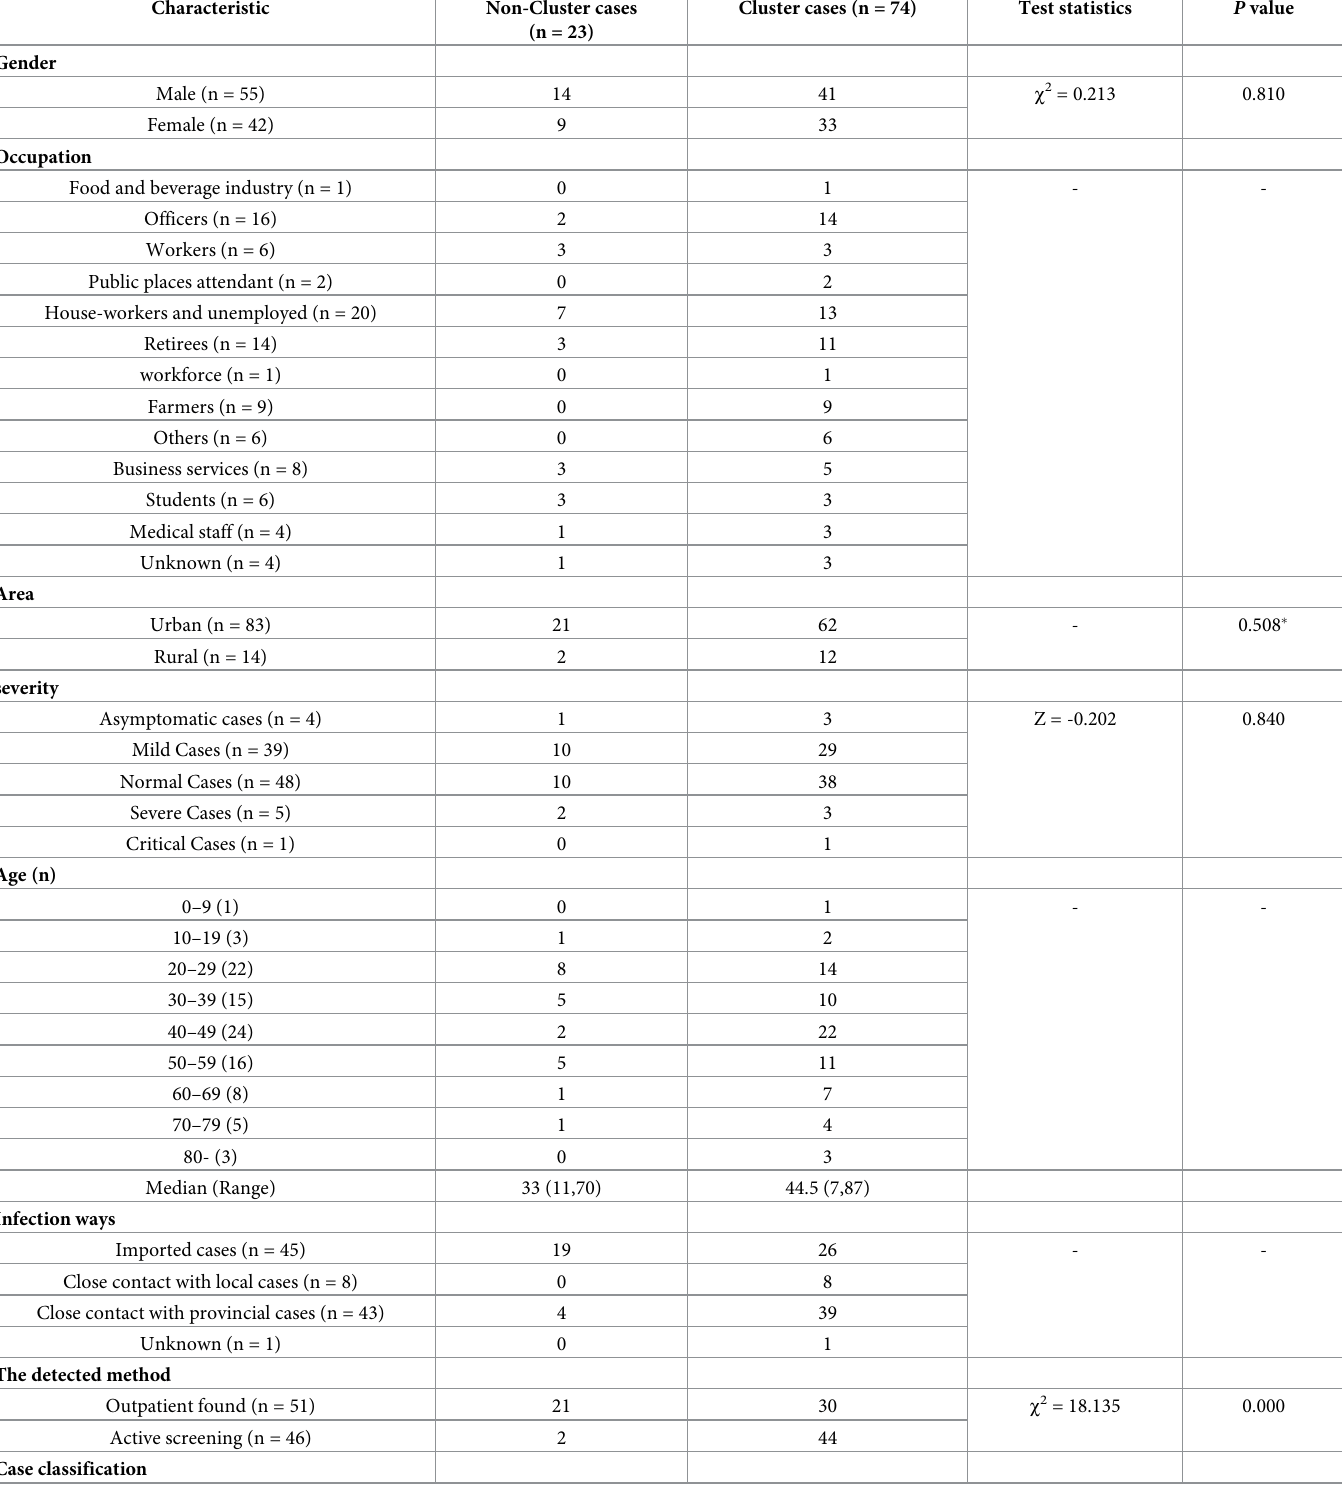
Table 3. Characteristics analysis of the first phase of the epidemic in Jilin